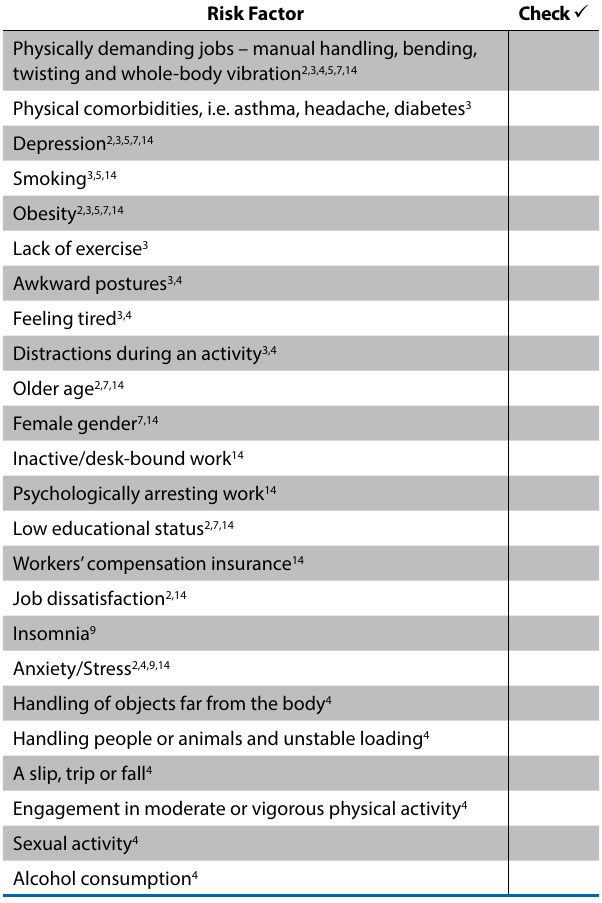
Table 1: Check list of risk factors for the development of back pain Risk Factor Check